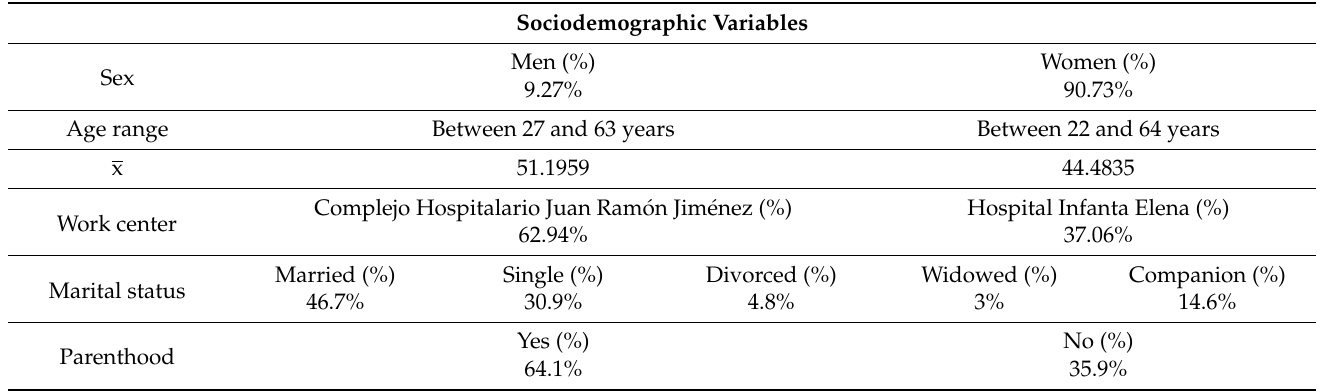
Table 1. Sociodemographic variables.